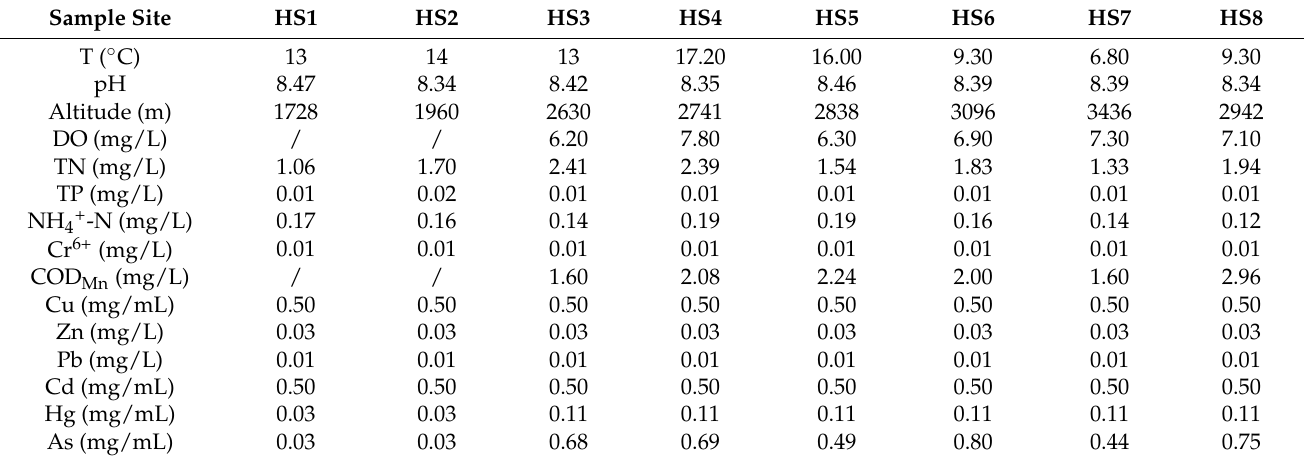
Table 1. The water quality parameters of the different sampling